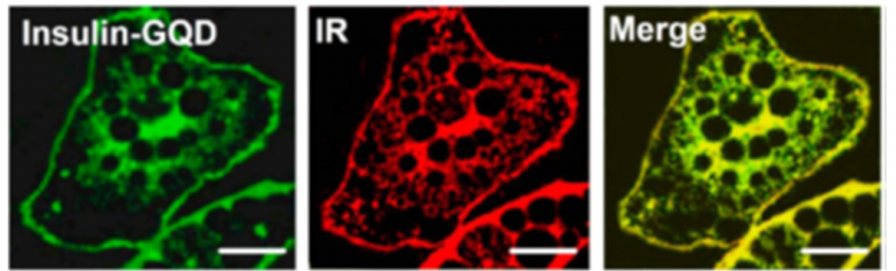
Figure 6. Confocal fluorescence images of fixed 3T3-L1 adipocytes. ( left ) Cells are stained with Insulin-GQDs; ( middle ) cells are treated with antibodies against insulin receptor B subunit followed by Atto647 NHS-conjugated secondary antibodies; ( right ) merged image to demonstrate insulin receptor staining. Scale bar = 10 µ m. Reproduced with permission [232]. Copyright 2013 American Chemical